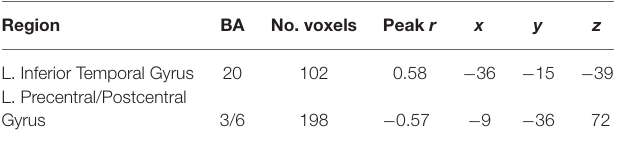
TABLE 2 | Brain regions showed significant ALFF-PLE correlations across subjects. Region